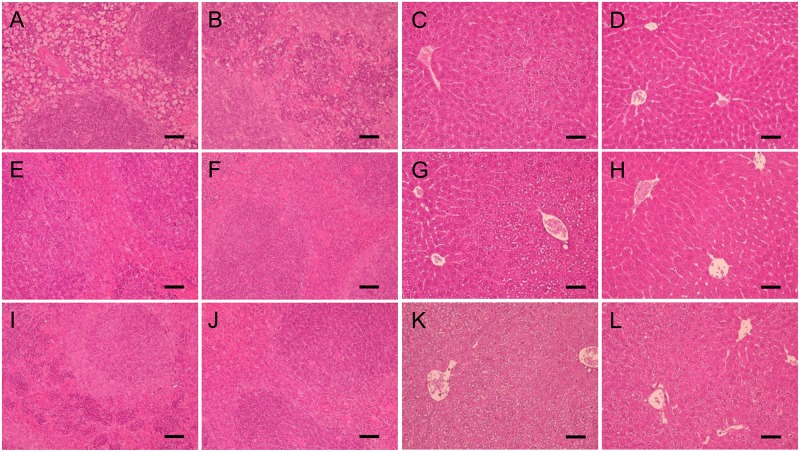
Representative histological sections of mouse spleens on the 1st (A, E, I) and 7th (B, F, J) postoperative days, and livers on the 1st (C, G, K) and 7th (D, H, K) postoperative days after transfusion with HbV/rHSA (A, B, C, D), mRBCs/rHSA (E, F, G, H) or rHSA (I, J, K, L).Bars = 50 μm. Hematoxylin/eosin stain.